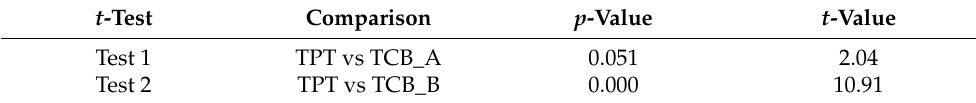
Table 3. Summary of t -test values between TPT and TCBs (TCB_A and TCB_B). t -Test